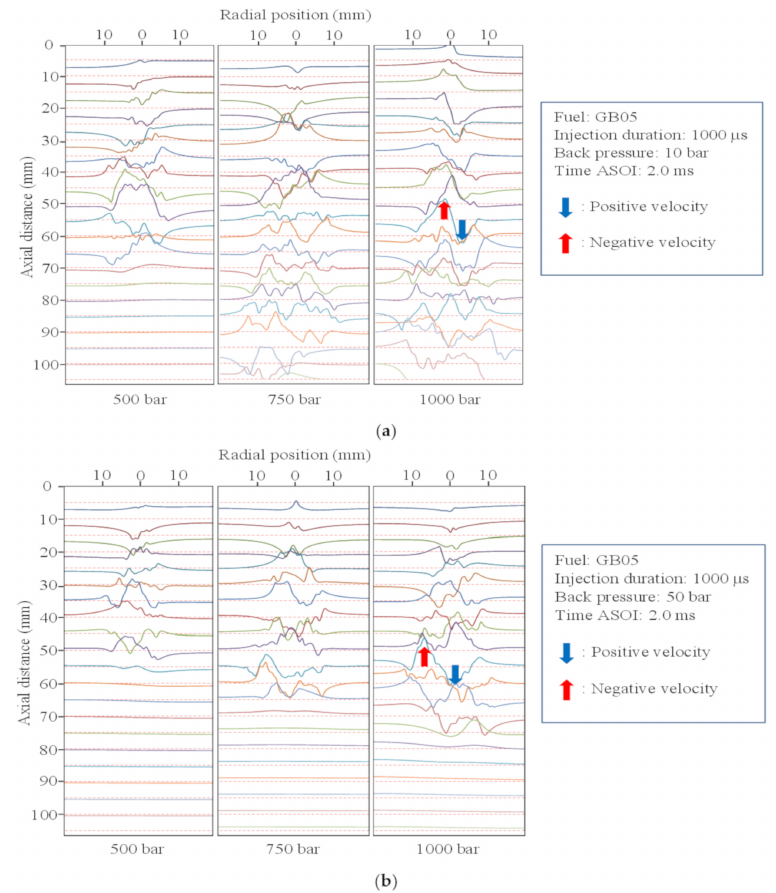
Figure 17. The axial velocity distribution profile of GB05 with di ff erent injection pressures at back pressures of ( a ) 10, and ( b ) 50